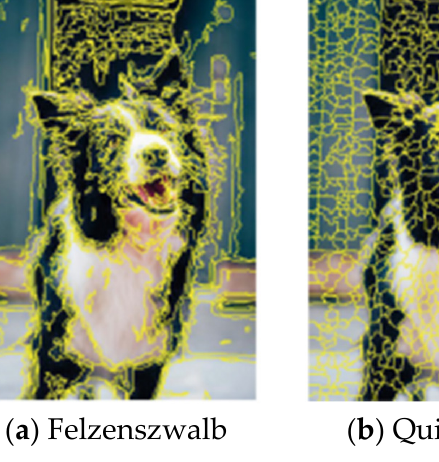
Figure A1. Comparison of super-pixel